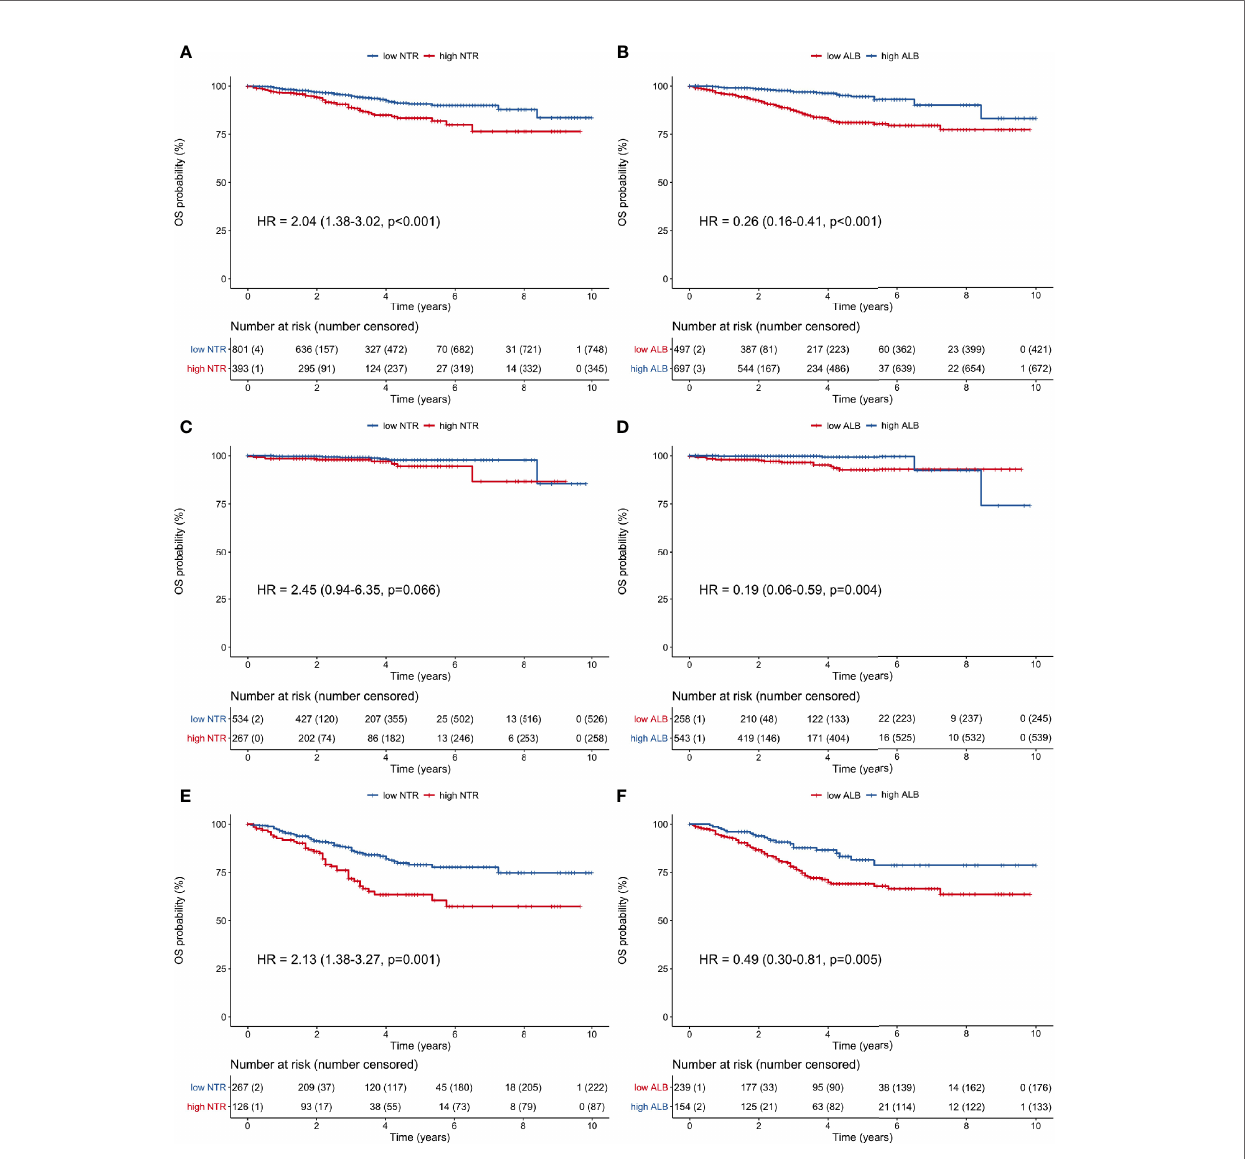
FIGURE 3 | Overall survival curves of patients grouped according to low or high 1-month neutrophil and albumin values. (A) all patients, neutrophil count; (B) all patients, albumin level; (C) stage I patients, neutrophil count; (D) stage I patients, albumin level; (E) stage II/III patients, neutrophil count; (F) stage II/III patients, albumin level. (ALB, albumin; HR, hazard ratio; NTR, neutrophil; OS, overall